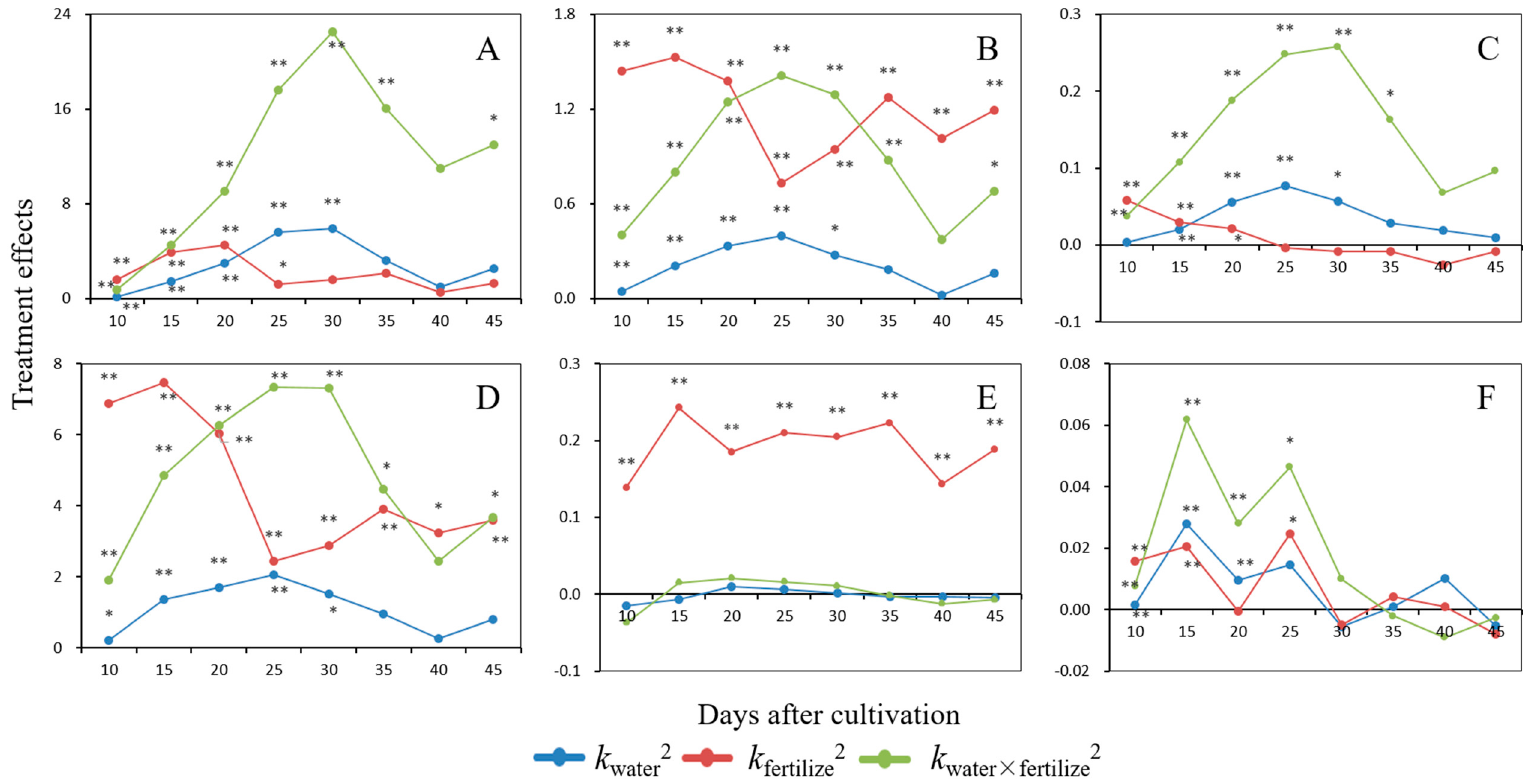
Figure 3. The effect of variance changes of water, fertilizer, and their combination during the leaf expansion. Note: ( A ) to ( F ) respectively represent the treatment effects of leaf area, leaf length, leaf width, leaf perimeter, leaf shape index, and leaf expansion rate. Notes: Levels of significance are indicated by asterisks: * p < 0.05; ** p < 0.01.